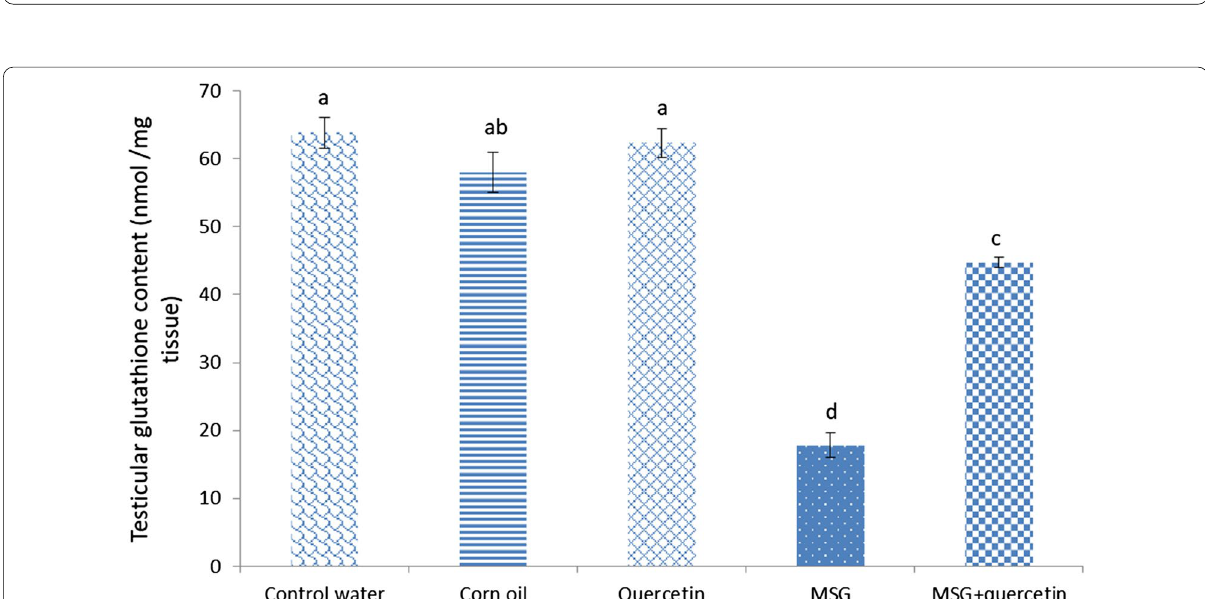
Fig. 2 Effect of quercetin on the level of glutathione content (nanomole per milligram tissue) in testis homogenate of MSG‑intoxicated male rats for 30 days. The number of samples in each group is six.Values were expressed as mean symbol(s) are significantly different at P <